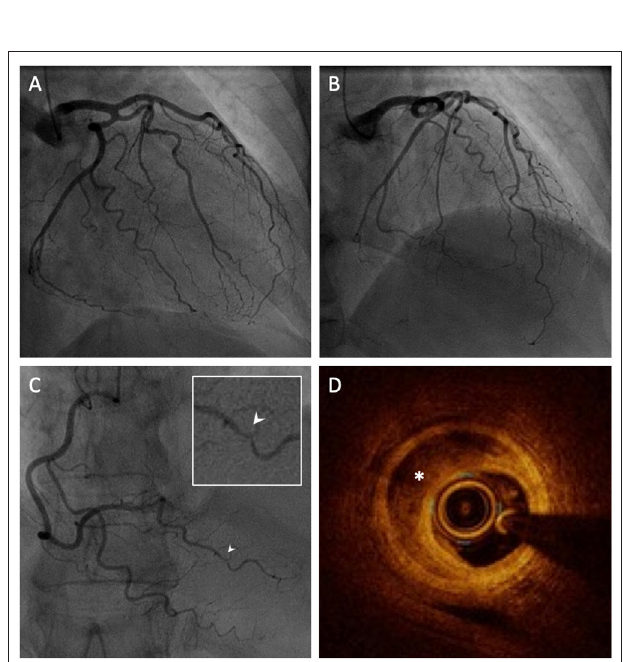
FIGURE 3 | Invasive coronary angiography (ICA) with intravascular imaging by optical coherence tomography (OCT). (A,B) ICA of the left coronary arteries revealing an absence of significant coronary artery disease. (C) ICA of the right coronary artery revealing a focal irregularity of the posterior left ventricular artery (PLV), magnified in the inset (white arrow). (D) OCT of the PLV reveals a false lumen with intramural haematoma (white asterisk) confirming the diagnosis of